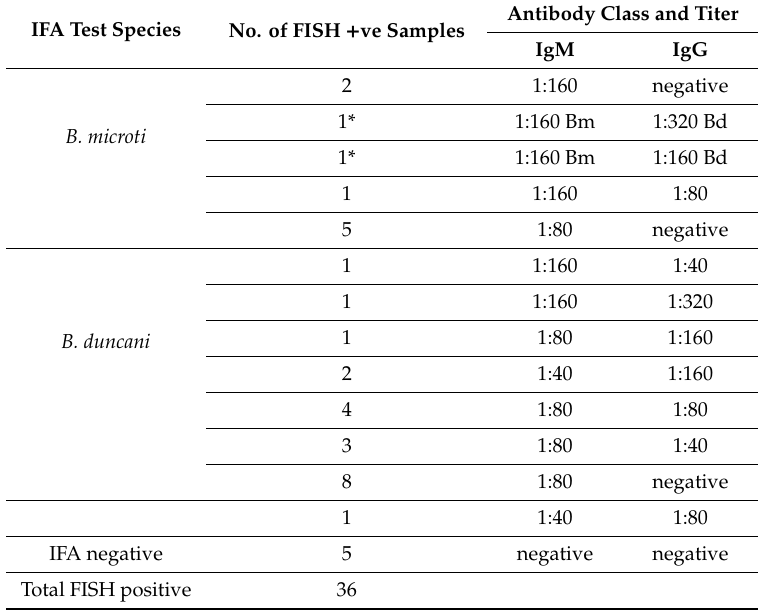
Table 2. IFA test results with the 36 Babesia genus FISH test positive samples from the USA. IFA Test Species No. of FISH + ve Samples